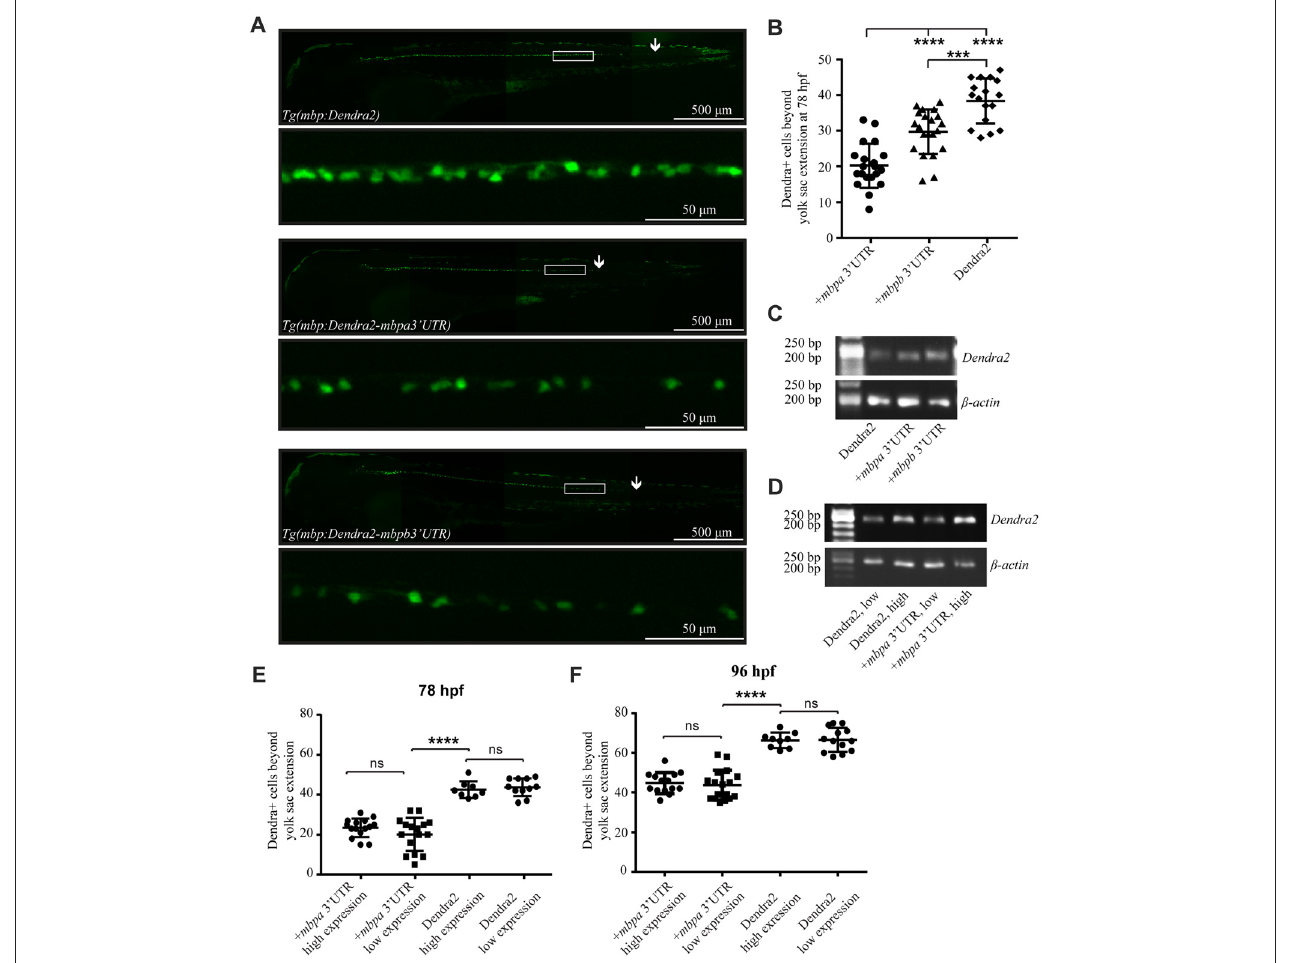
FIGURE 5 | The 3’UTRs from mbpa and mbpb inhibit protein translation in vivo . (A) Lateral views of representative full-size transgenic zebrafish at 78 hpf and magnifications of the boxed areas. The most posteriorly located Dendra2-positive cell in each fish is marked with an arrow. (B) The number of Dendra2-positive cells caudal to the yolk sac extension was counted at 78 hpf. At least 17 fish were analyzed from each strain. (C) RT-PCR with RNA extracted from transgenic zebrafish larvae at 78 hpf as template. Primers recognized Dendra2 or β - actin (control). (D) RT-PCR with RNA extracted from transgenic zebrafish larvae grouped into “low expression” and “high expression” based on fluorescent intensity at 78 hpf as template. Primers recognized Dendra2 or β - actin (control) (E,F) The number of Dendra2-positive cells caudal to the yolk sac extension in transgenic larvae sorted based on the intensity of fluorescence in individual cells at 78 (D) or 96 (E) hpf. 8–16 fish were analyzed for each group. Results are shown ± SD. ns = not significant, ∗∗∗ p < 0.001, ∗∗∗∗ p <